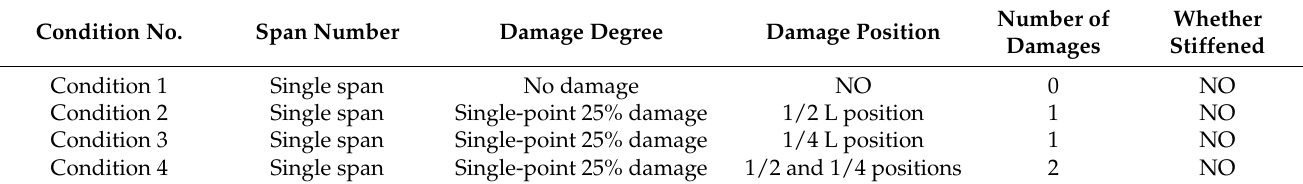
4 of 37 Figure 1. Schematic diagram of experimental beam models.